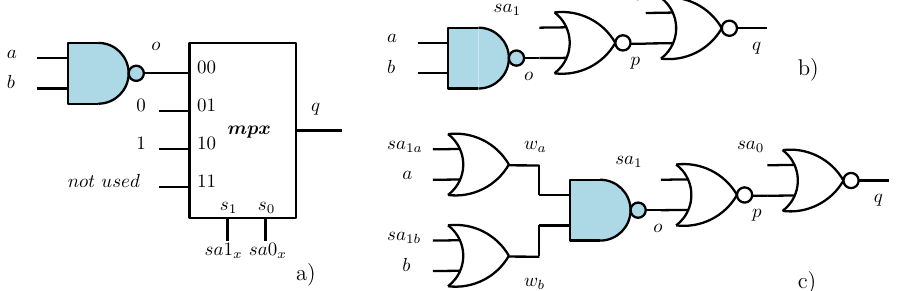
Figure 1. Examples of gate-level fault-injection techniques at the output of the shaded NAND gate with a multiplexer ( a ) or a simplified network ( b ). Subfigure ( c ) represents the model for the same NAND gate with faults at gate inputs and